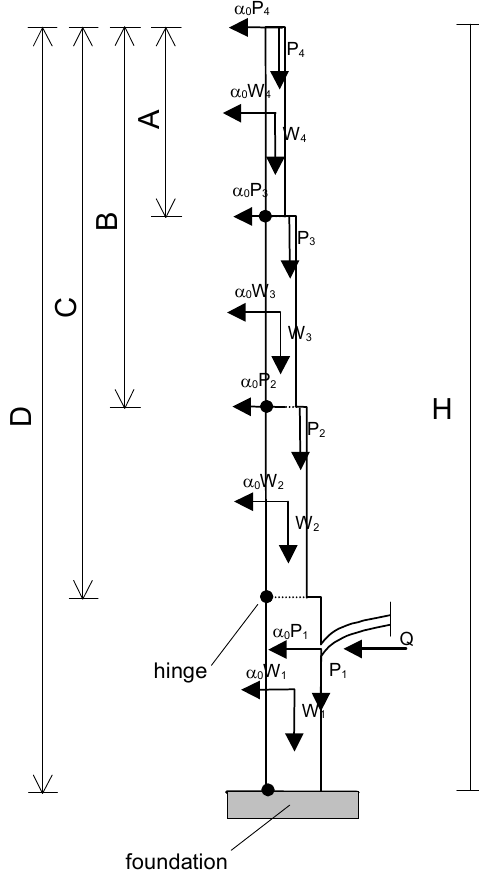
are the vault or the floor vertical i